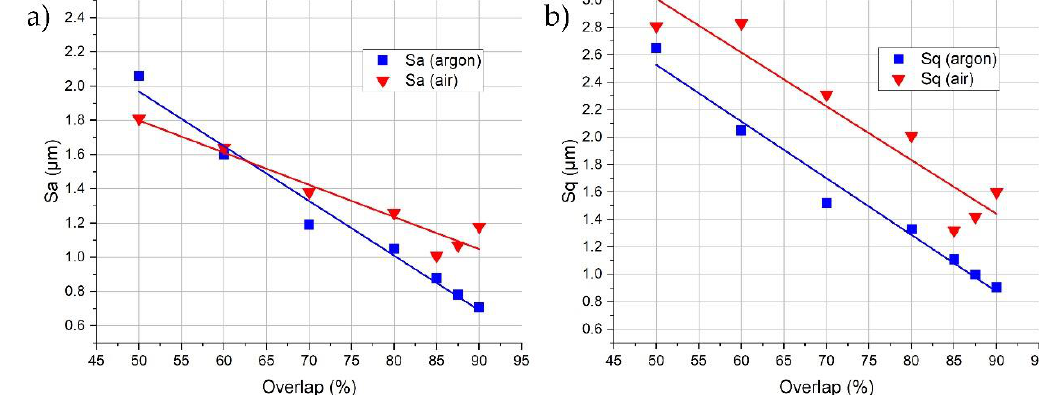
Figure 10. Evaluation of Sa ( a ) and Sq ( b ) surface roughness parameters for the trials Laser Polished in accordance with Table 2.